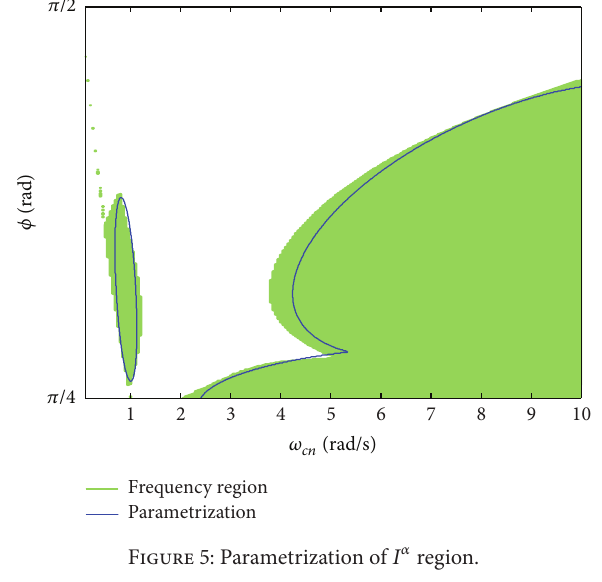
Figure 5: Parametrization of 𝐼 𝛼 region.